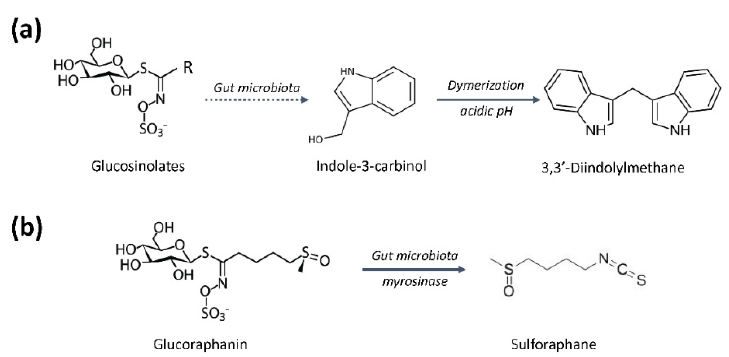
Figure 5. Role of gut microbiota in the production of active phytochemicals from cruciferous vege- bles. ( a ) Indole-3-carbinol and 3,3 (cid:48) -diindolylmethane are generated from inert glucosinolates tables. ( a ) Indole-3-carbinol and 3,3 ′ -diindolylmethane are generated from inert glucosinolates after digestion. ( b ) Glucoraphanin, a glucosinolate found almost exclusively in broccoli is converted into